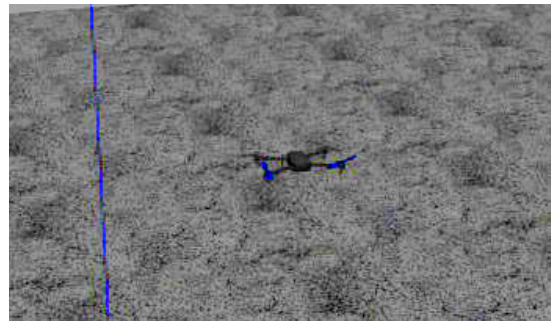
Figure 12. UAV used in the simulation